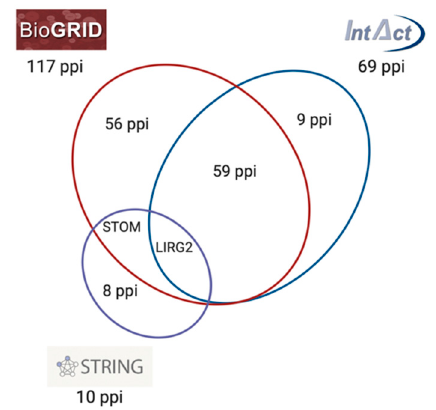
Figure 4. Schematic representation of PON2 protein–protein interactions (ppi) network reported by BioGRID, IntAct, and STRING databases. The intersection between circles represents common ppi shared by the different databases.